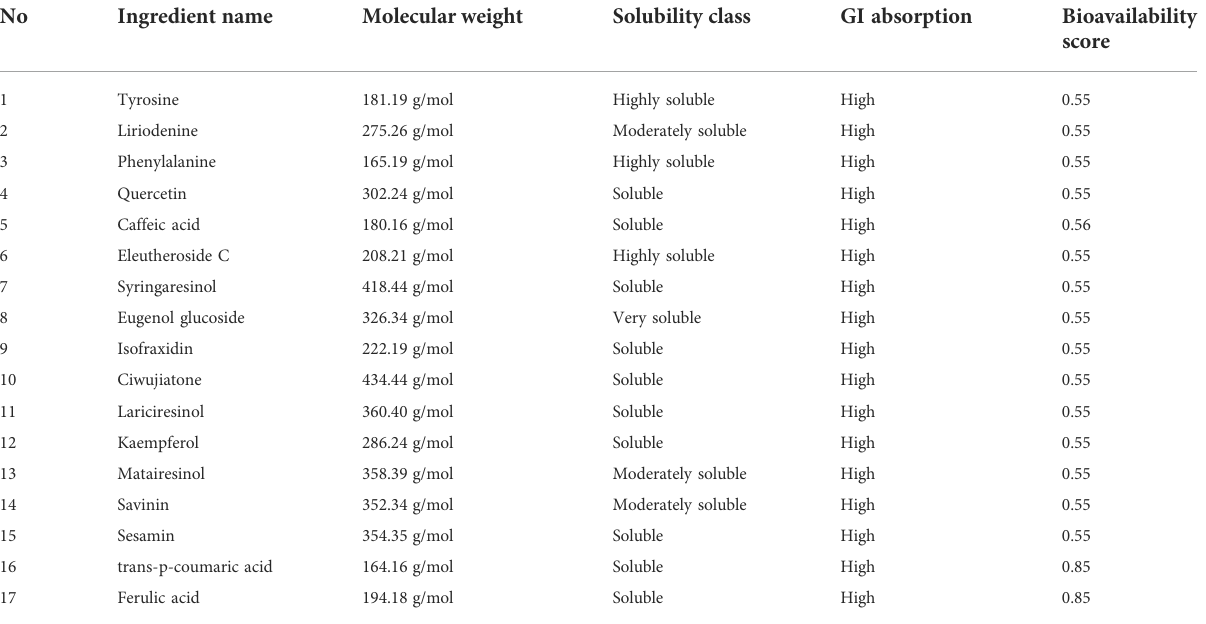
TABLE 2 CWT active ingredients screening